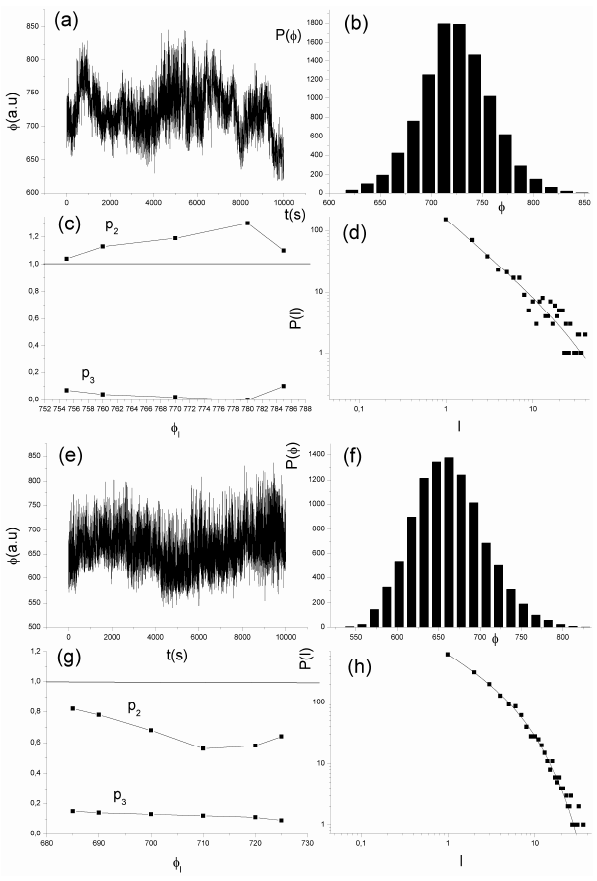
Fig. 3. (a) The CW almost 2.7h long associated with the L’Aquila EQ. (b) The histogram of the φ values of (a) . (c) The corresponding “healthy” exponents p 2 , p 3 vs. the end of laminar region φ l . The critical limit ( p 2 = 1 ) is also depicted. (d) A representative exam- ple of a laminar distribution of the CW for φ l = 780. (e) A noncrit- ical excerpt of the recorded EM time series, following shortly after the CW of (a) , almost 2.7h long. (f) The histogram of φ values of (e) . (g) The “pathological” exponents p 2 , p 3 vs. the end of laminar region φ l . The critical limit ( p 2 = 1 ) is also depicted. (h) A repre- sentative example of a laminar distribution of the noncritical excerpt for φ l = 690. The departure from critical state is